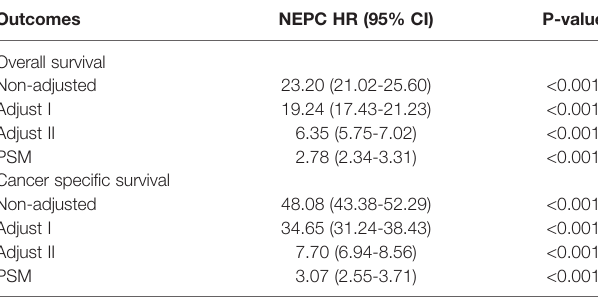
TABLE 5 | Multivariable Cox proportional hazard